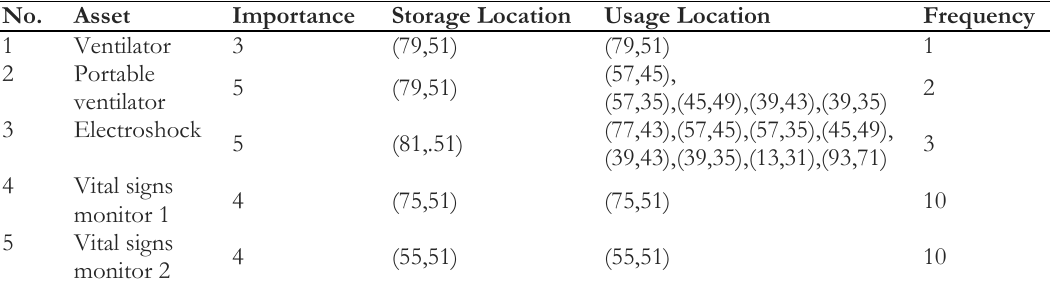
Table 4. List of medical assets.